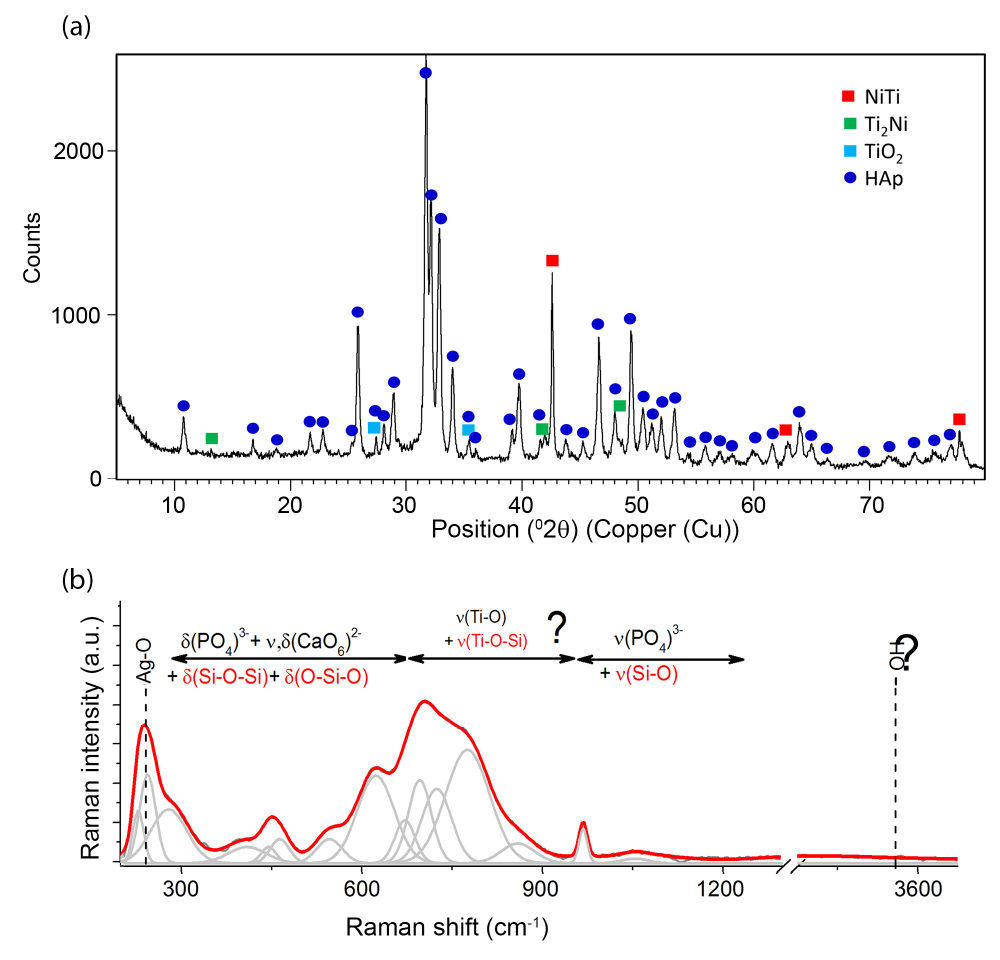
Figure 8. XRD pattern collected for coating 5:1 (50 V, 120 s) after heat treatment ( a ) and exemplary Raman spectrum. The bands were fitted using Voigt function with the minimum number of components ( b ).